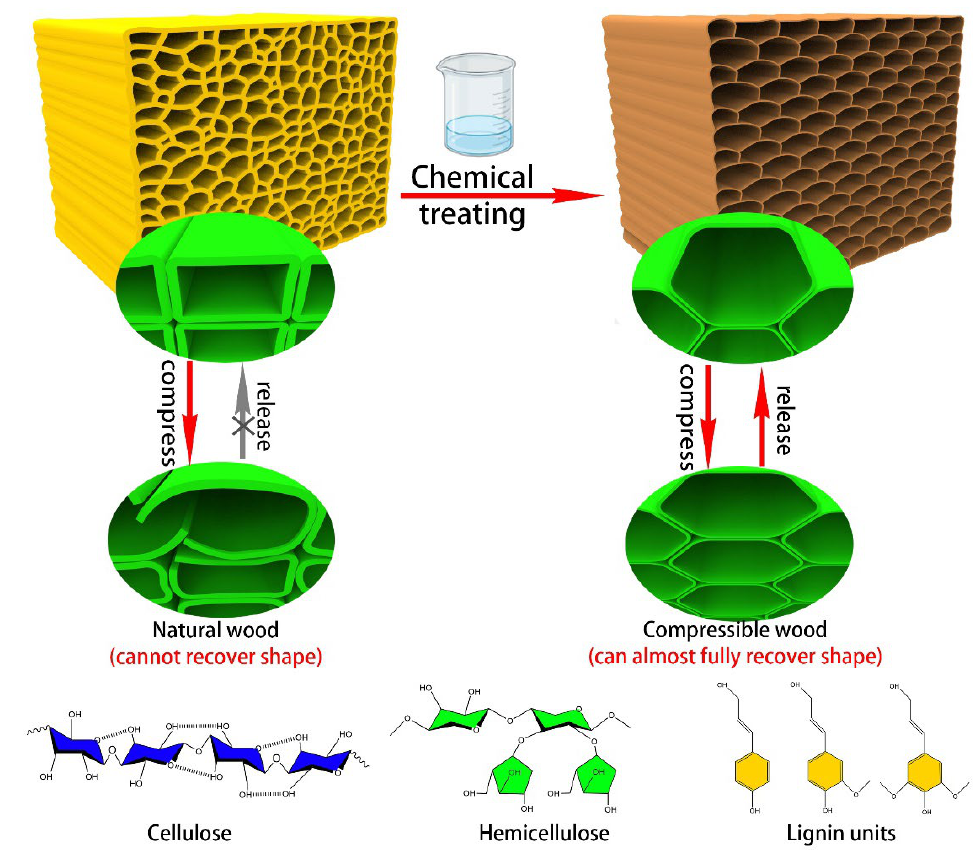
Figure 1. C omparison between natural wood and compressible wood. Figure 1. Comparison between natural wood and compressible